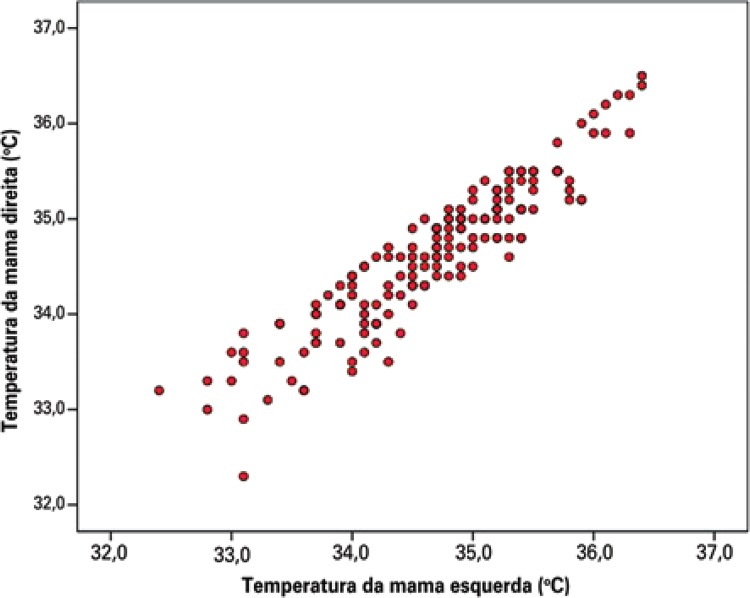
Correlação entre a temperatura média das mamas direita e esquerda (r=0,927; p<0,001)